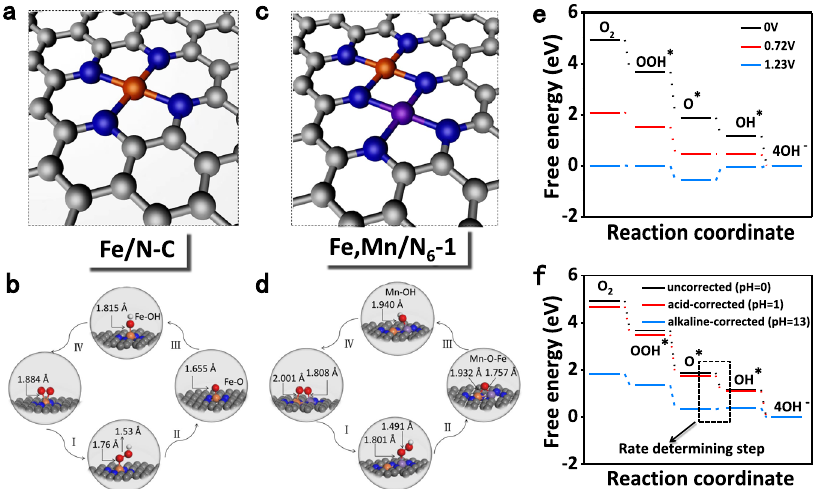
Fig. 5 DFT calculations of the ORR activity on Fe,Mn/N – C and Fe/N – C catalysts. The optimized structure of ( a ) Fe/N – C and ( c ) Fe,Mn/N – C. Optimized atomic structures for the main process of an ORR: b Fe/N – C and d Fe,Mn/N – C. e The pathways for Fe,Mn/N – C are summarized at U = 0 V, 0.72 V, and 1.23 V, respectively. f pH-corrected free energy diagram of the Fe,Mn/N 6